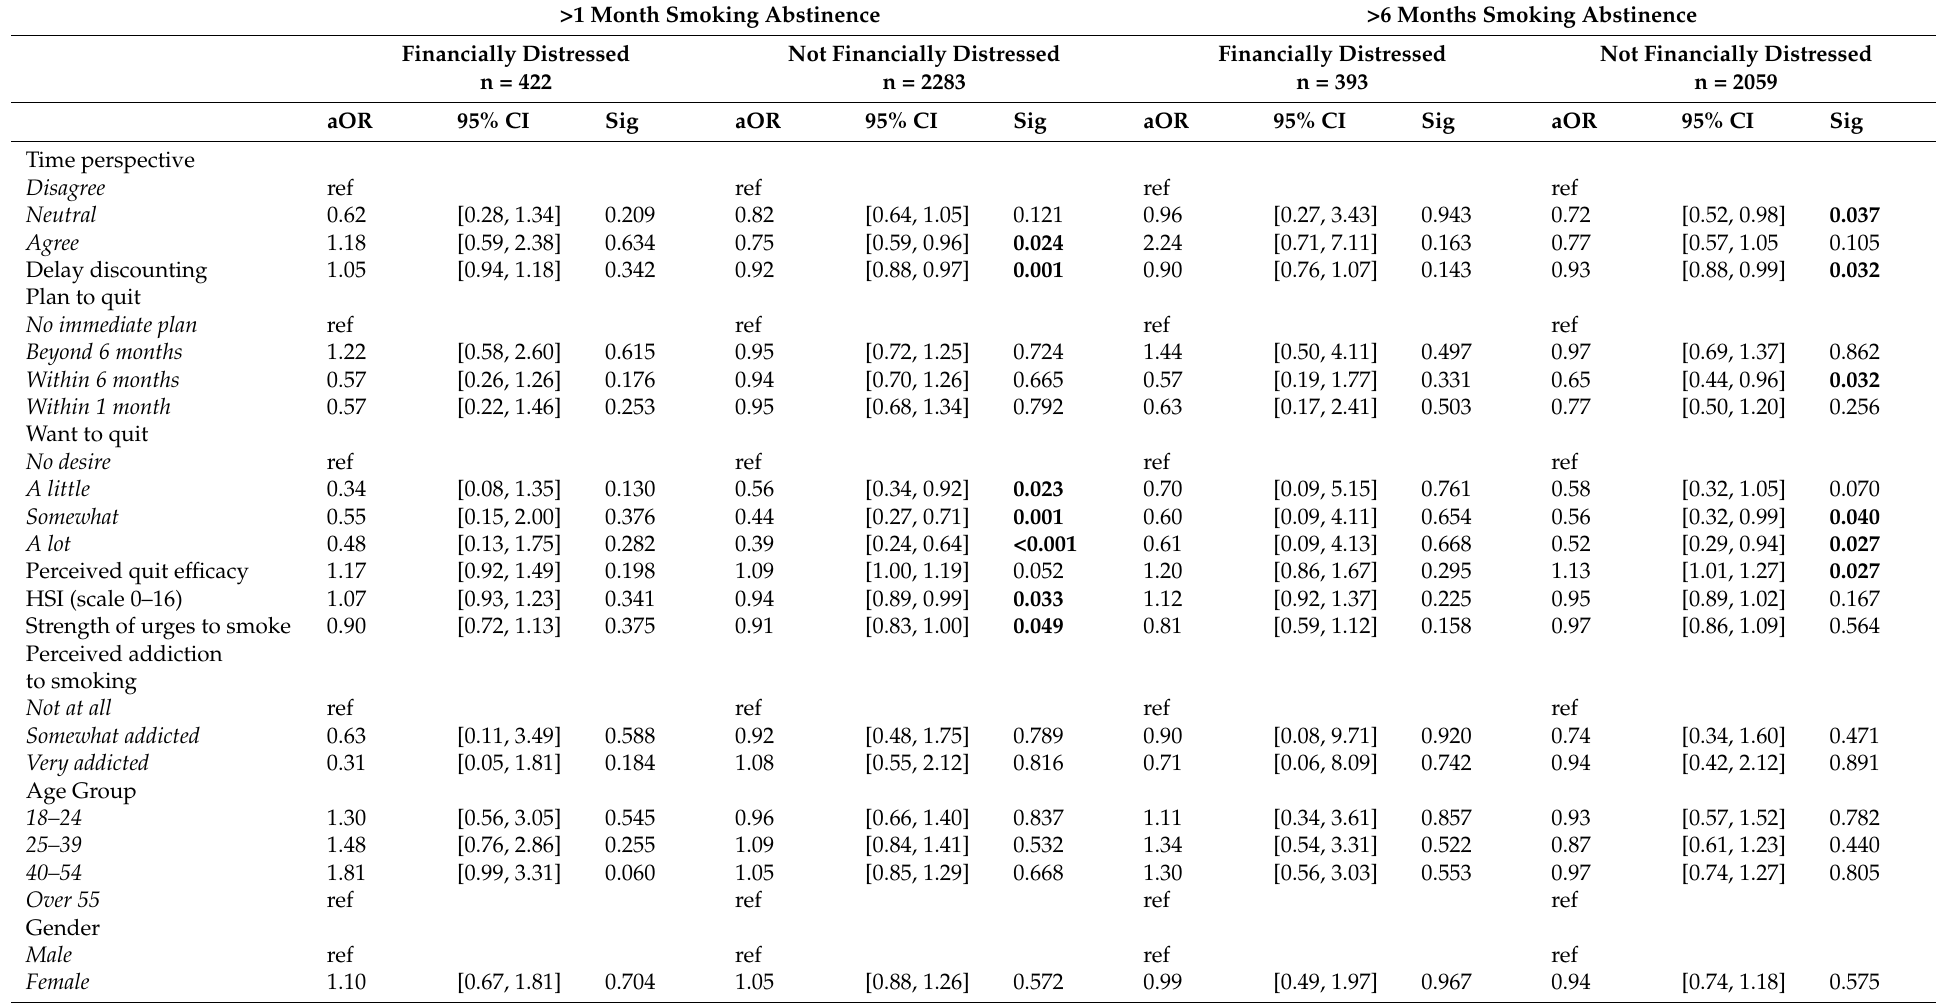
Table 3. Generalized estimating equations (GEE) showing probability of >1 month and ≥ 6 months quit success as function of delay discounting, time perspective, motivational, demographic and dependence measure variables: stratified by financial